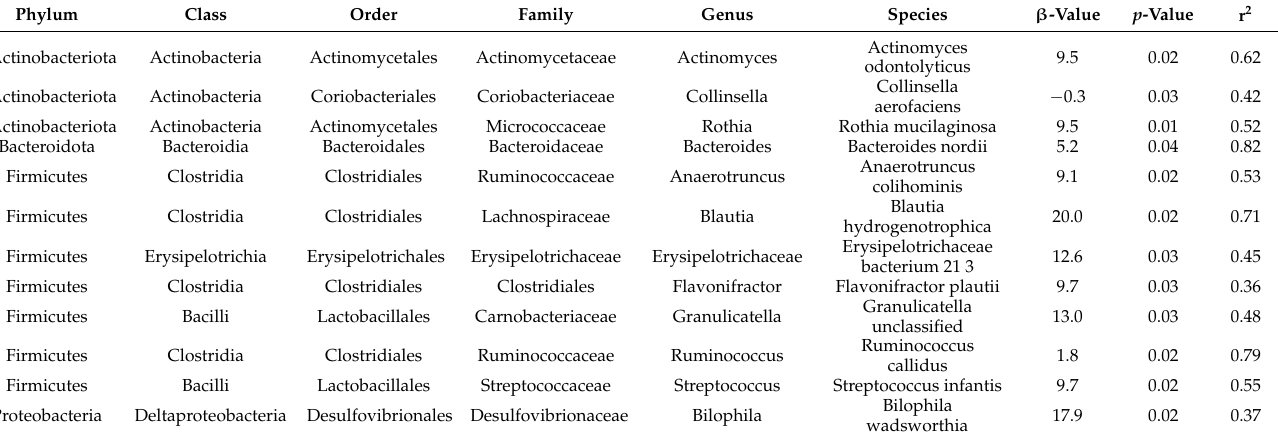
Table 3. Association between fecal microbial abundance at the species level and plasma TMAO levels throughout the